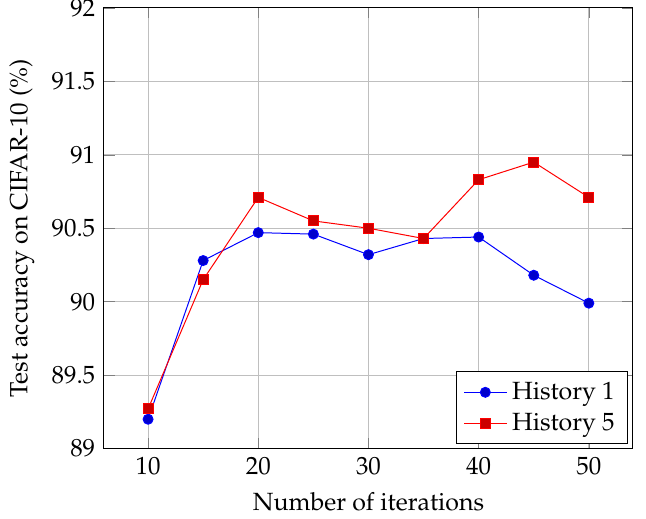
Figure 4. Accuracy on CIFAR-10 as a function of the number of iterations. The number of parameters is fixed at 40 k, and pooling is evenly spaced in order to be performed 4 times, plus one last time in the end. Experiments were performed 5 times and the mean accuracy is